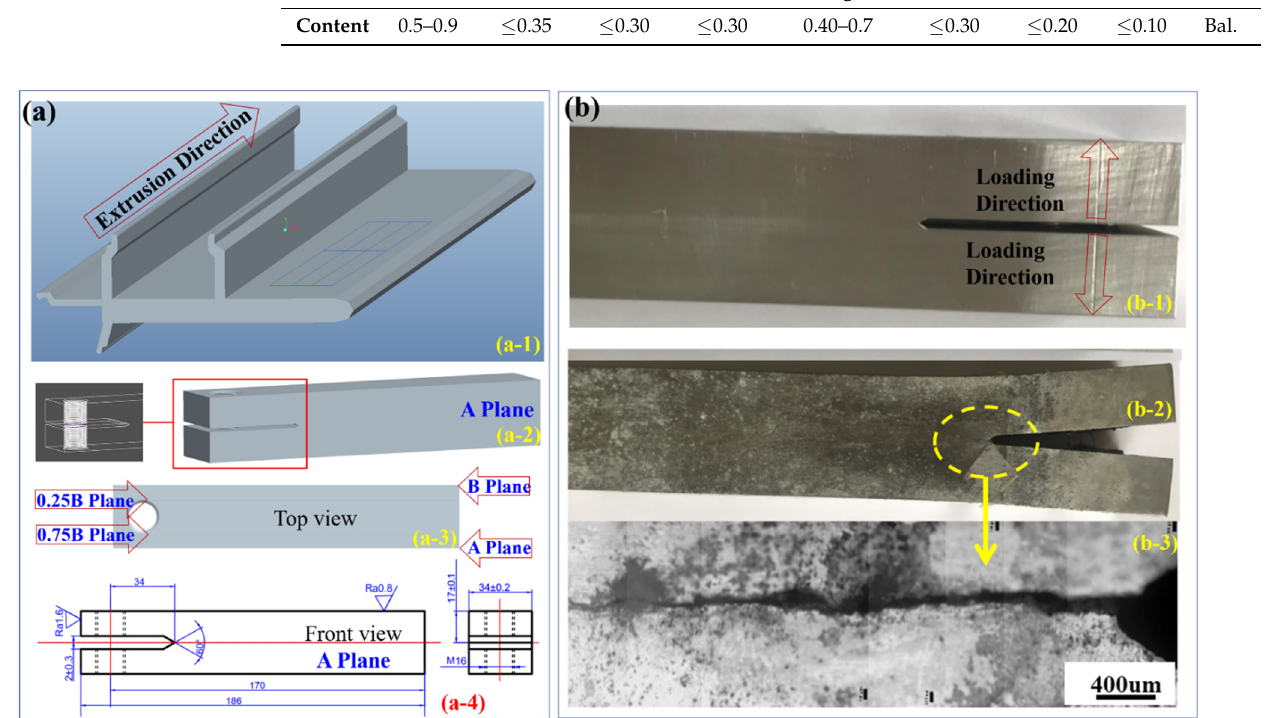
Figure 1. The fabrication of DCB specimens: ( a ) the schematic diagrams of the pre ‐ cracked self ‐ stressed DCB specimens along the extrusion direction; ( b ) the specimen before and after the SCC test together with the enlarged region with the propagated cracks. The additional numbers identify the various views of the DCB specimen. After the SCC test, the DCB specimen was cut at the quarter positions referring to the surfaces, which are referred to as 0.25B plane and 0.75B plane, respectively. Table 1. Chemical composition of the commercial 6005A ‐ T6 alloy at manufacture (wt %). Elements Content